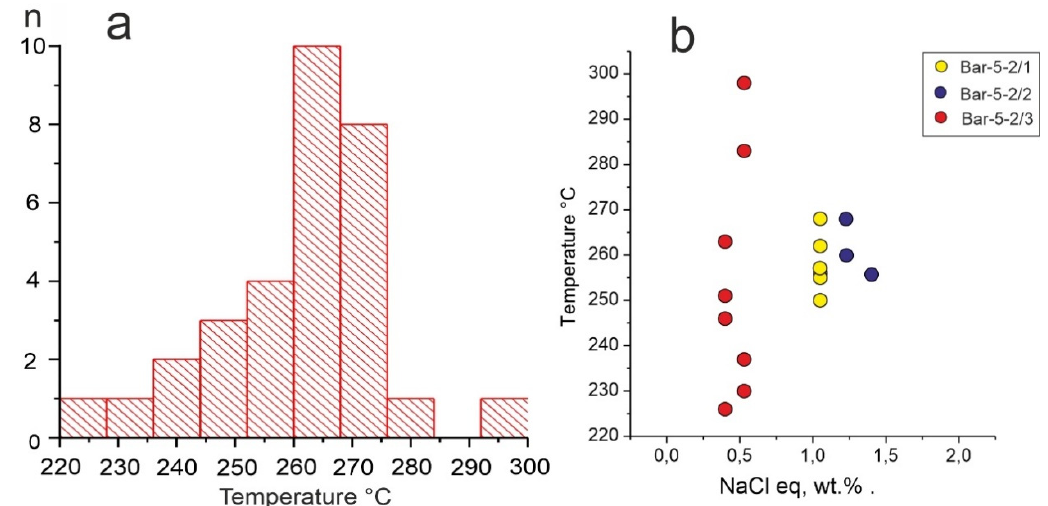
Figure 12. Results of the fluid inclusion study: ( a ) histogram of homogenization temperatures of fluid inclusions in quartz of the gold-sulfosalt-quartz association from the Northern Zone of the Baranyevskoe deposit; ( b ) temperature of homogenization of inclusions versus their salinity. Bar-5-2/1 to Bar-5-2/3 are different sample Bar-5-2 areas of the gold-sulfosalt-quartz association. Table 7. Summary of the microthermometric study of fluid inclusions in quartz from the gold-sulfosalt-quartz association.